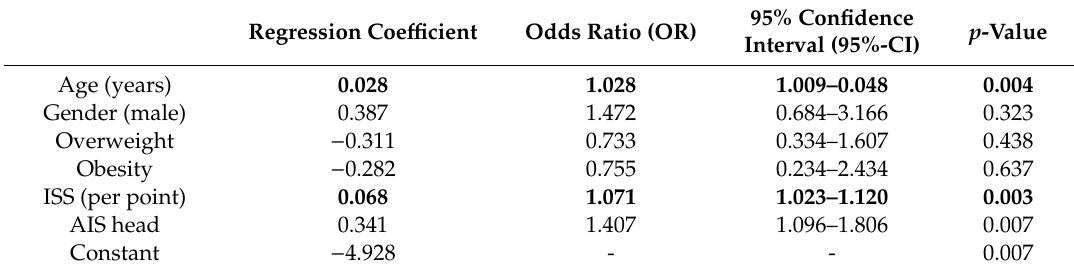
Table 3. Multivariate regression analysis of patients with AIS chest < 3 referring to